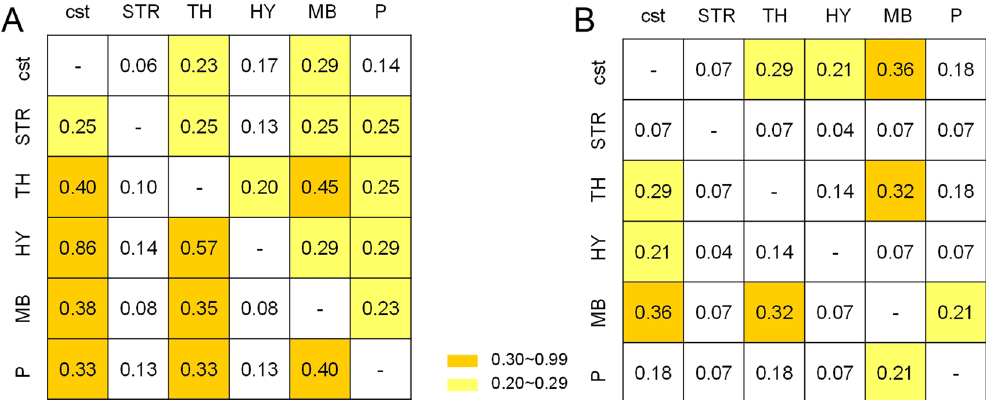
For example, we used “corticostriatal” or “corticothalamic” for those single-region projection neurons that only project to the striatum or the thalamus, respectively, and we used “TP” for multidirectional projection neurons that project to the thalamus and the pons. We abbreviated several names of the main projection regions: C-cst, corticospinal tract; S-STR, striatum; T-TH, thalamus; H-HY, hypothalamus; M-MB, midbrain; P, pons. The above region abbreviations were sorted by ascending spatial distance of the barrel field to the region. We found that 43% of L5 type I neurons had multi-region corticofugal projections and 19% of L5 type I neurons had more than two regions of corticofugal projection. In contrast, only 10% of L6 neurons had multidirectional corticofugal pro- jections and none of the L6 neurons had more than three directions of corticofugal projections (Supplementary Table S2). The L5 type I neurons showed different projection profiles under multi-region projection mode. Table 1 lists the ratio values of the multi-region projection neurons that target a certain region to all the neurons that project to the same region. The two region projection data show that the ratio in the striatum is the lowest, which is less than 0.4, but the thalamus, hypothalamus, midbrain and pons all have ratios greater than 0.6. Specifically, the hypothalamus has a 100% two-region projection ratio. This means that if a L5 type I neuron has projections to the hypothalamus, then it must have collateral projections to other regions. Additionally, the multi-region projection (more than two) ratio of the hypothalamus is greater than other regions. We pooled the L5 type I neurons that had no less than two directions of corticofugal projection and measured the two occurrence frequency parameters. A collaboration matrix was used to quantify the “posterior probability” of another projection region given the neuron projection to the current region (Fig. 4A). For example, the neuron projecting to the hypothalamus (HY) has extra projections to the corticospinal tract (cst) with a probability of 0.85. Another coexistence matrix was applied to measure the ratio of some neurons projecting to the two regions to all the neurons having at least two projection regions (Fig. 4B). The results suggested that the cst, TH and MB are key targets of the multidirectional projection mode: “CM” and “TM” modes occurred most frequently, and TH and MB had greater “extra projec- tion” ratios in all regions. The abovementioned “strong synergistic” feature of the hypothalamus was also reflected in the high values of the collaboration matrix.